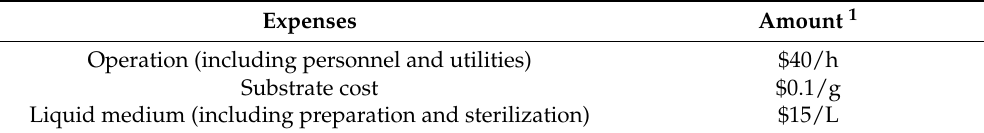
Table 3. Costing and operational expenses.